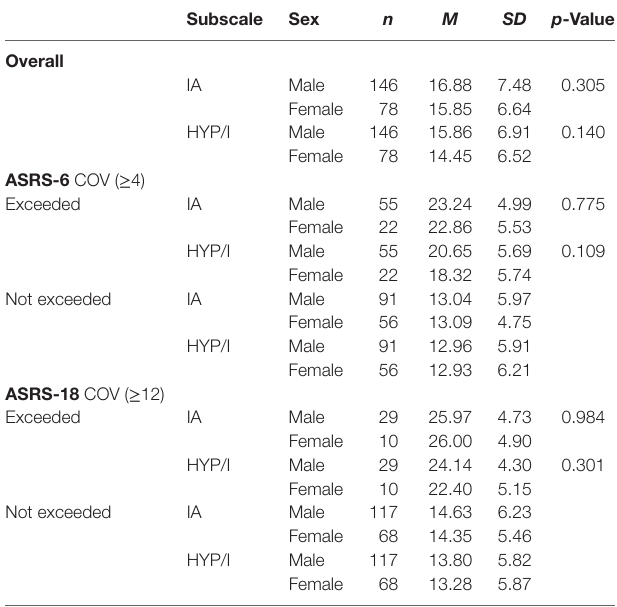
TaBle 3 | Descriptive statistics of ASRS-v1.1 subscales IA and HYP/I by COV and sex.